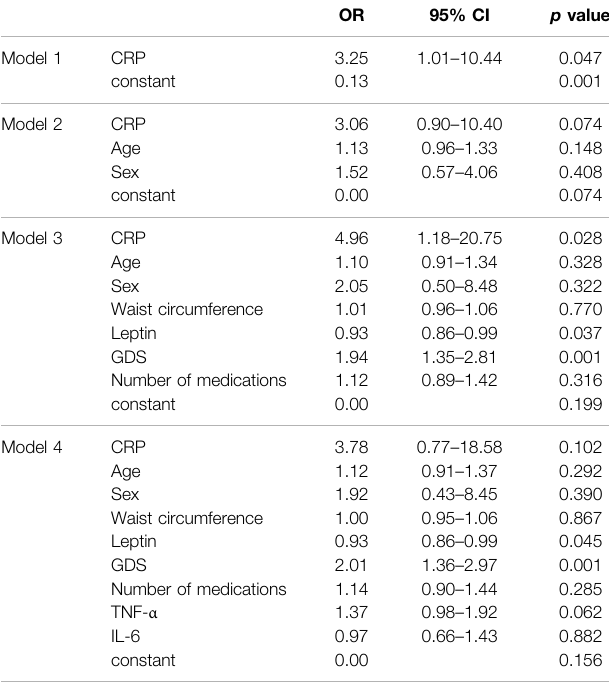
TABLE 2 | Association between in fl ammation (CRP ≥ 5.0 mg/L) and appetite ( n =158).Oddsratios(OR) and 95% con fi denceintervals(CI) for moderate appetite (vs. (very) good appetite) — unadjusted (model 1) and adjusted for potential confounders (models 2 – 4) (binary logistic regression). OR 95%